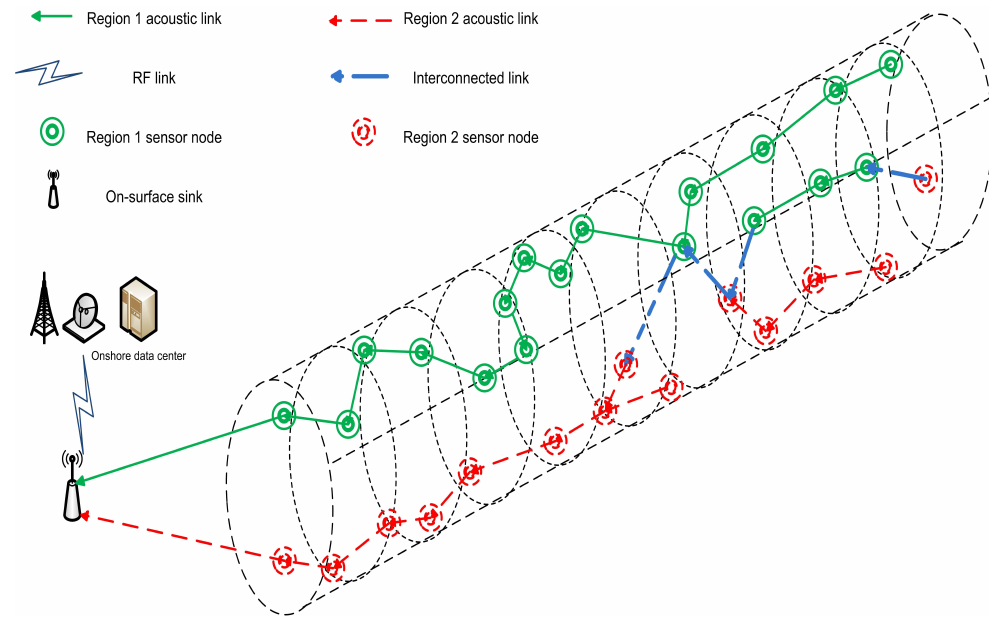
Figure 6. 2-chain based